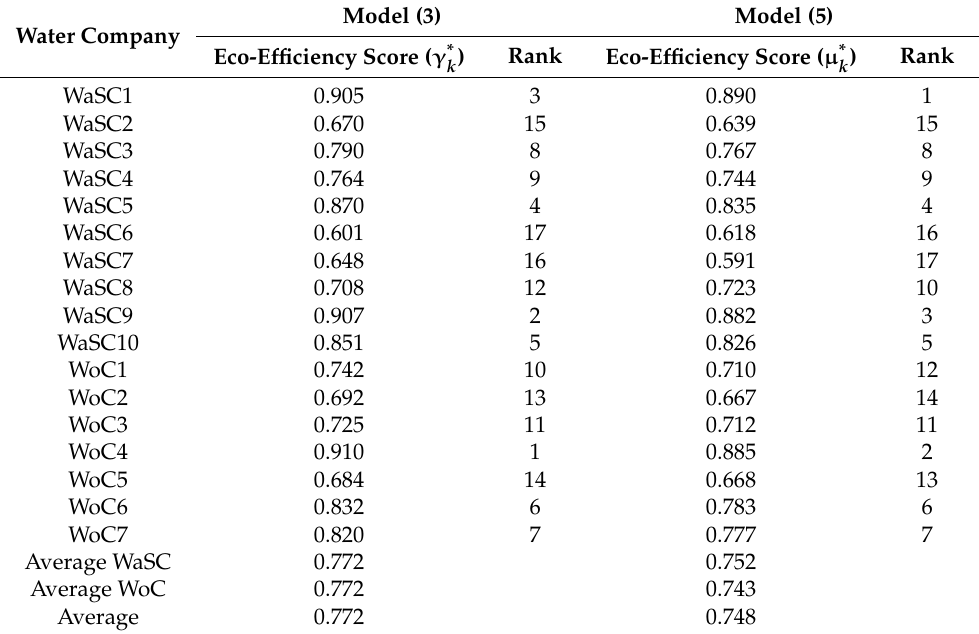
Table 4. Cross-eco-efficiency scores and ranking of water companies.